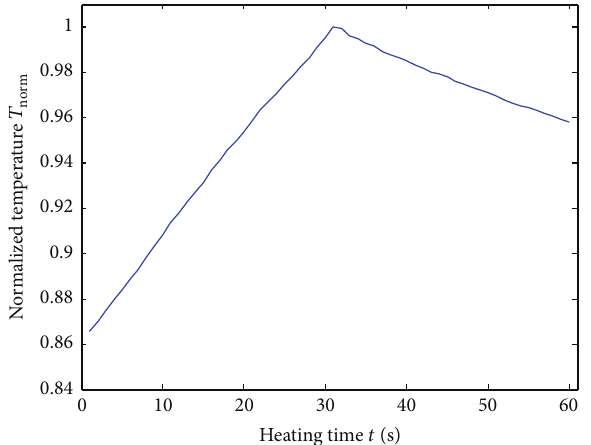
Figure 6: Measured temperature changes of selected (𝑥, 𝑦)